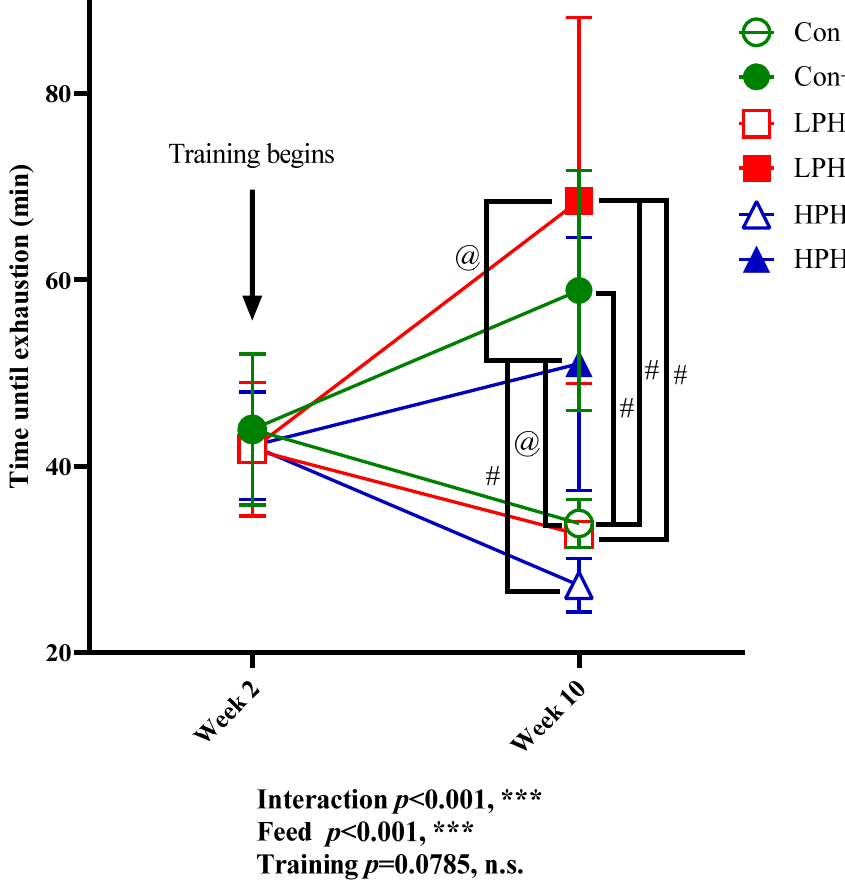
Figure 3. Maximal exercise capacity. Con, Con+T, LPHF, LPHF+T, HPHF, and HPHF+T represent chow diet, chow diet plus training, low-protein high-fat diet, low-protein high-fat diet plus training, high-protein high-fat diet, and high-protein high-fat diet plus training, respectively. Feed, training, and interaction indicate a dominant effect of diet, treadmill exercise, and the interactive effect between feed and training, respectively. n.s., no significance was observed. *** p < 0.001. @, p < 0.05; #, p < 0.001. Data are presented as the mean ± SD. n = 8 for each group. Significance of differences between means was determined by Tukey’s post hoc test when ANOVA revealed a significant effect from the interaction of diet and training.